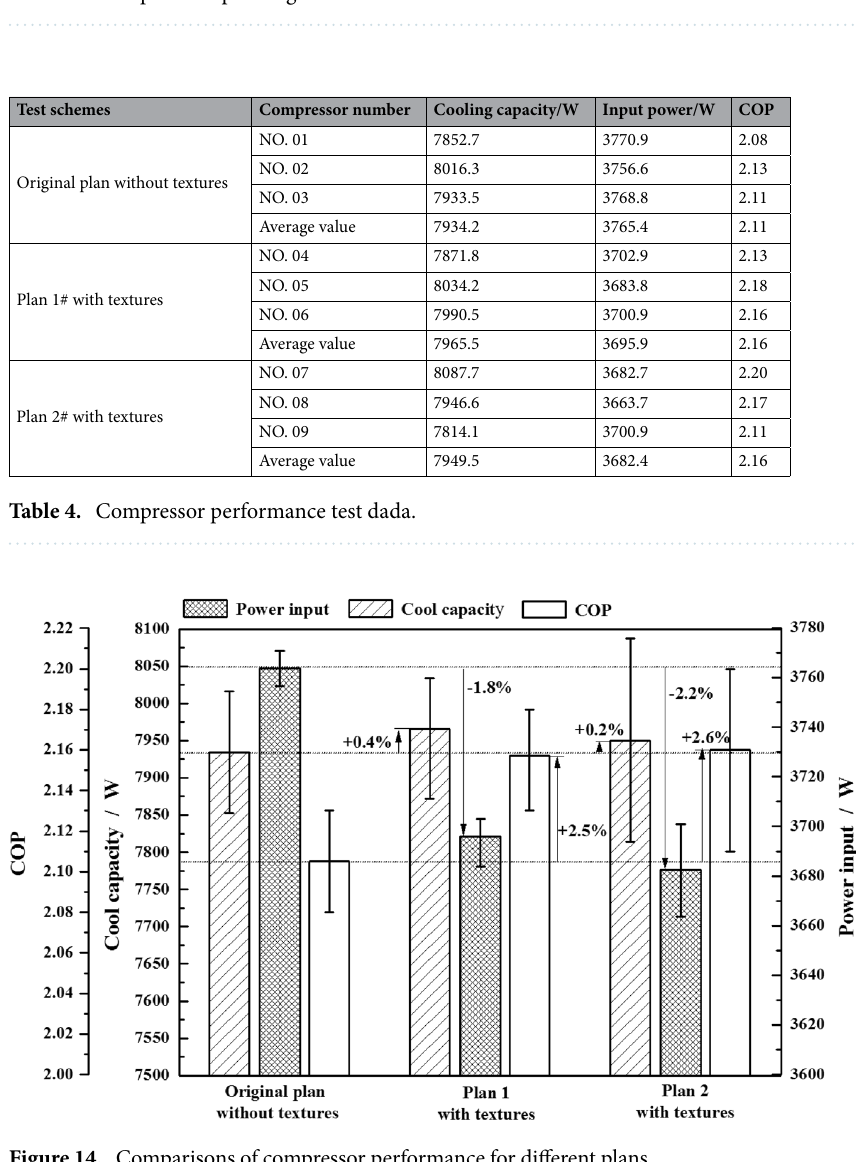
Table 3. Compressor operating conditions.